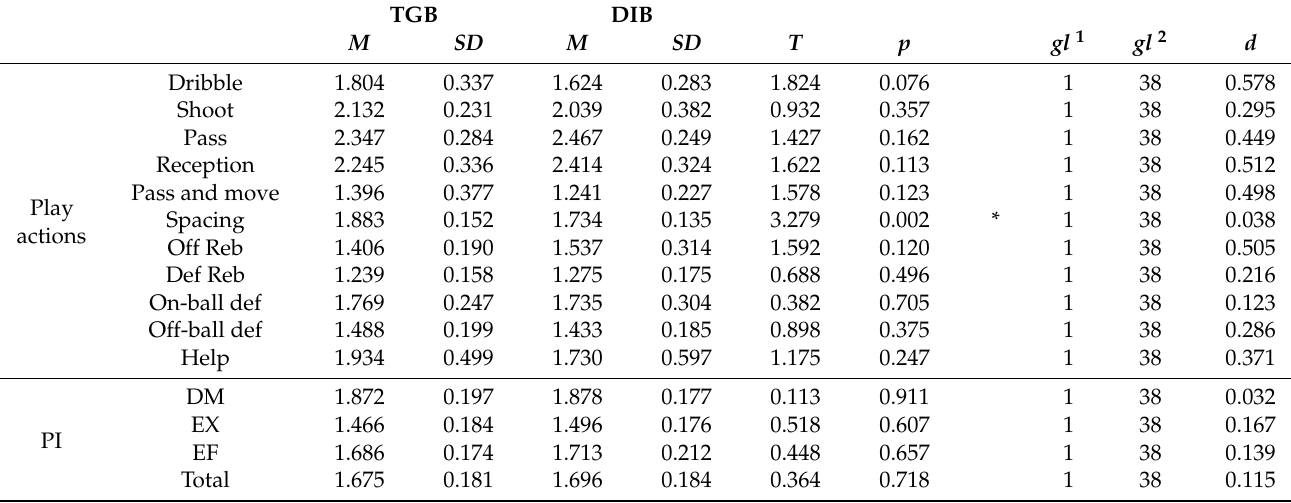
Figure 1. Characteristics of the students after the pre-test. * p < 0.05. Table 2. Differences in performance between students in the DIB and TGB units in the